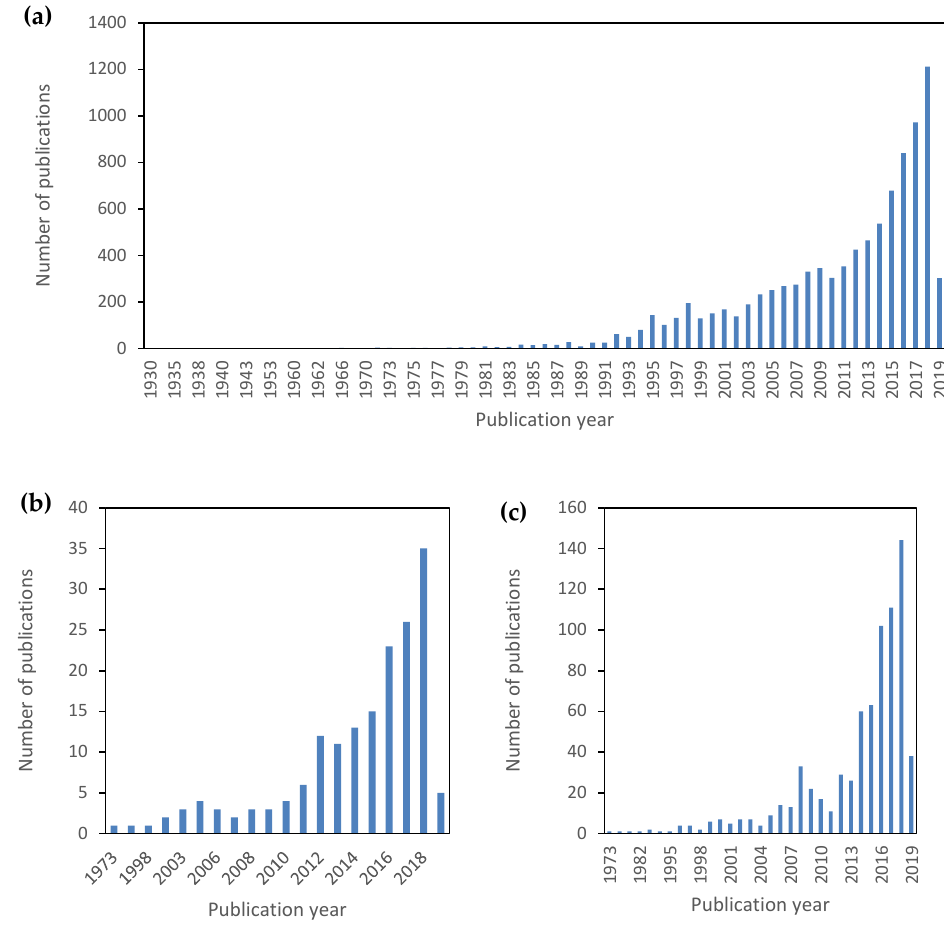
Figure 2. Trends in articles published worldwide on aerogels: ( a ) aerogels (search criteria: “aerogels”), ( b ) natural polymer-based aerogels (search criteria: “polysaccharide aerogels” OR “protein aerogels”), and ( c ) hybrid aerogels (search criteria: “hybrid aerogels”). Source: Scopus (search date: 26/02/2019).